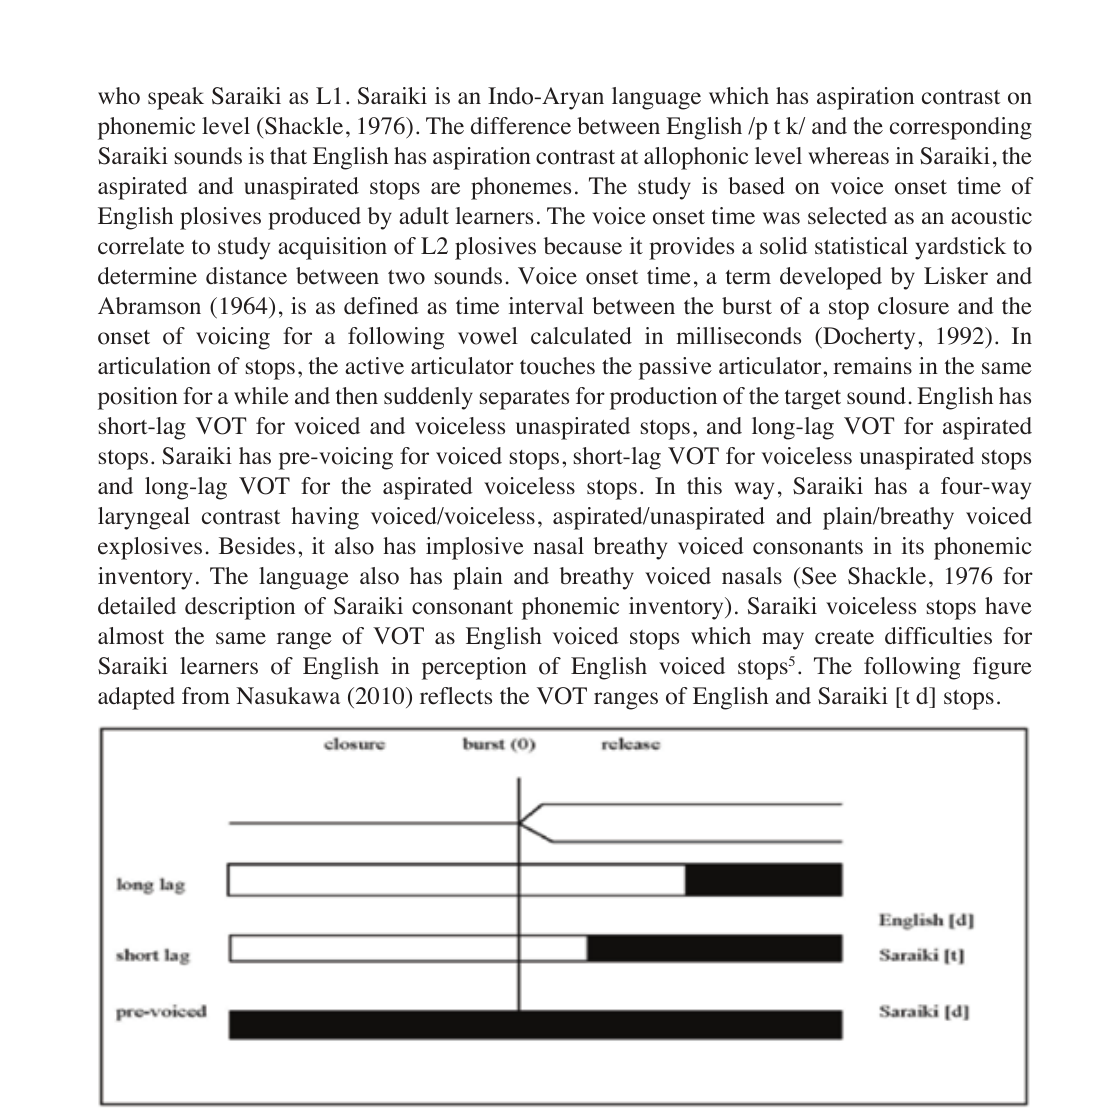
Figure 1: VOT settings of English and